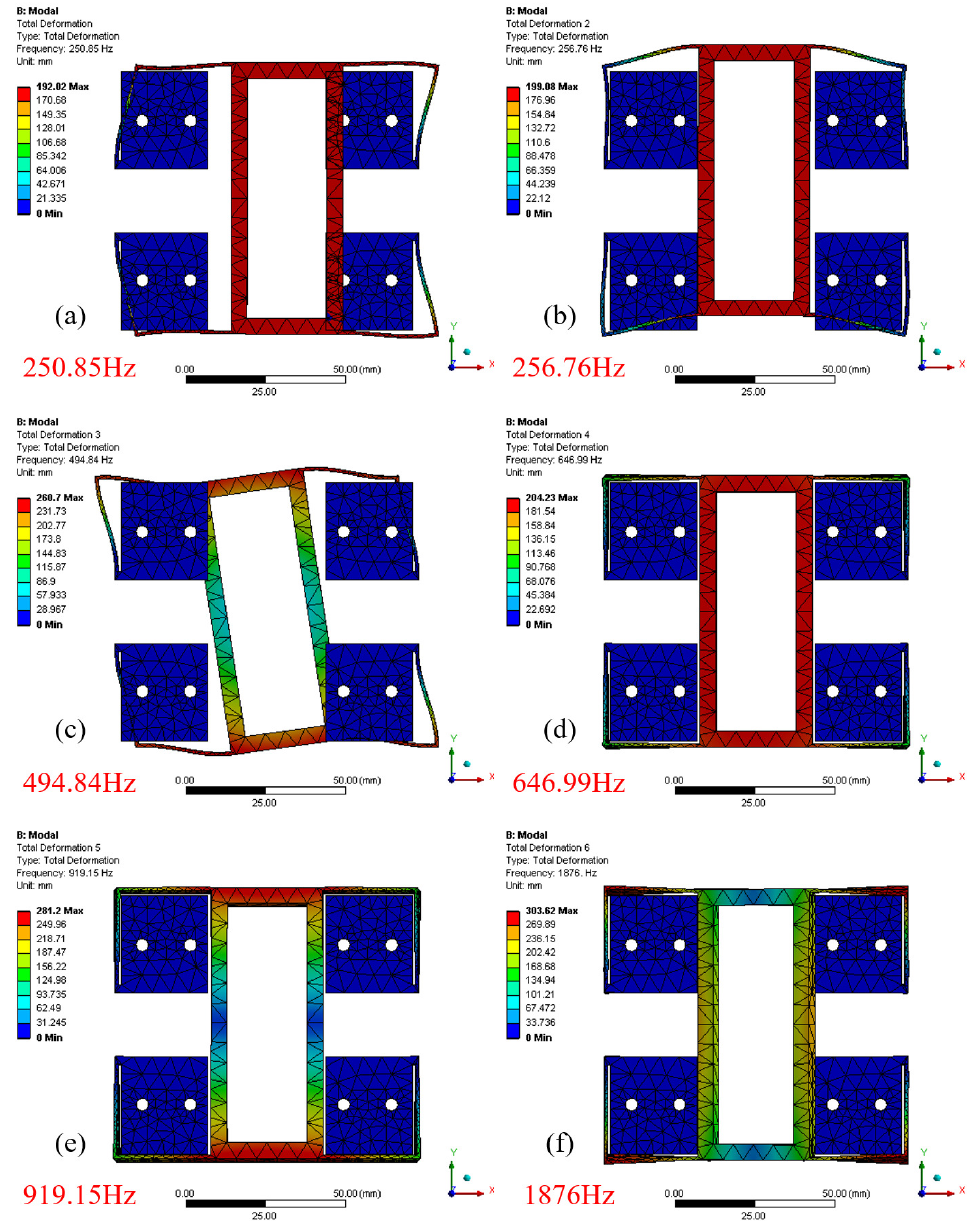
Figure 5. The FEA results. ( a ) The first mode: 250.85 Hz, x -axis direction. ( b ) The second mode: 256.76 Hz, y -axis direction. ( c ) The third mode: 494.84 Hz. ( d ) The fourth mode: 646.99 Hz, z -axis direction. ( e ) The third mode: 919.15 Hz. ( f ) The third mode: 1876